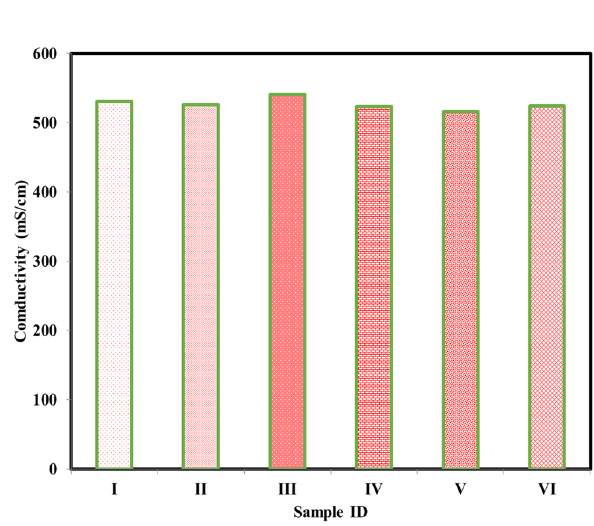
Fig. 5 Total dissolved solids (TDS) that were measured in terms